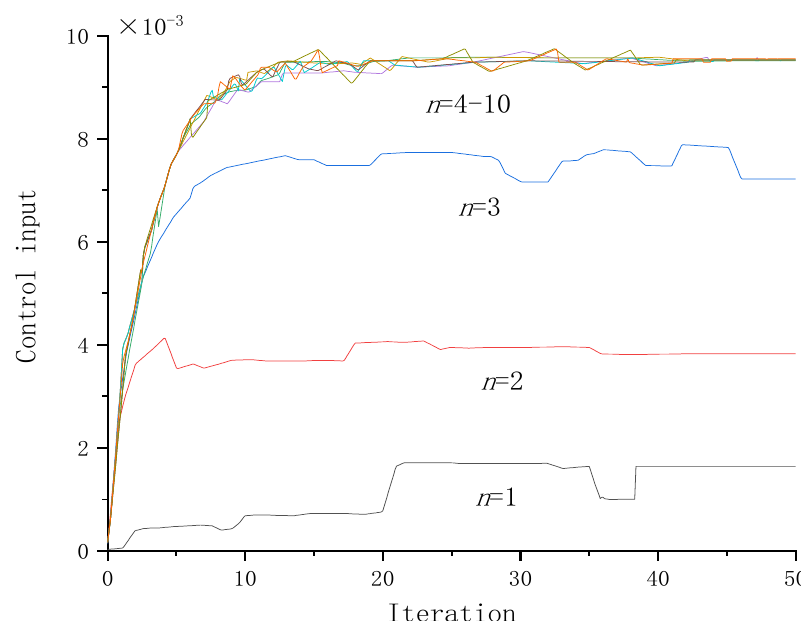
Figure 7. Effect of the number of neurons on convergence.